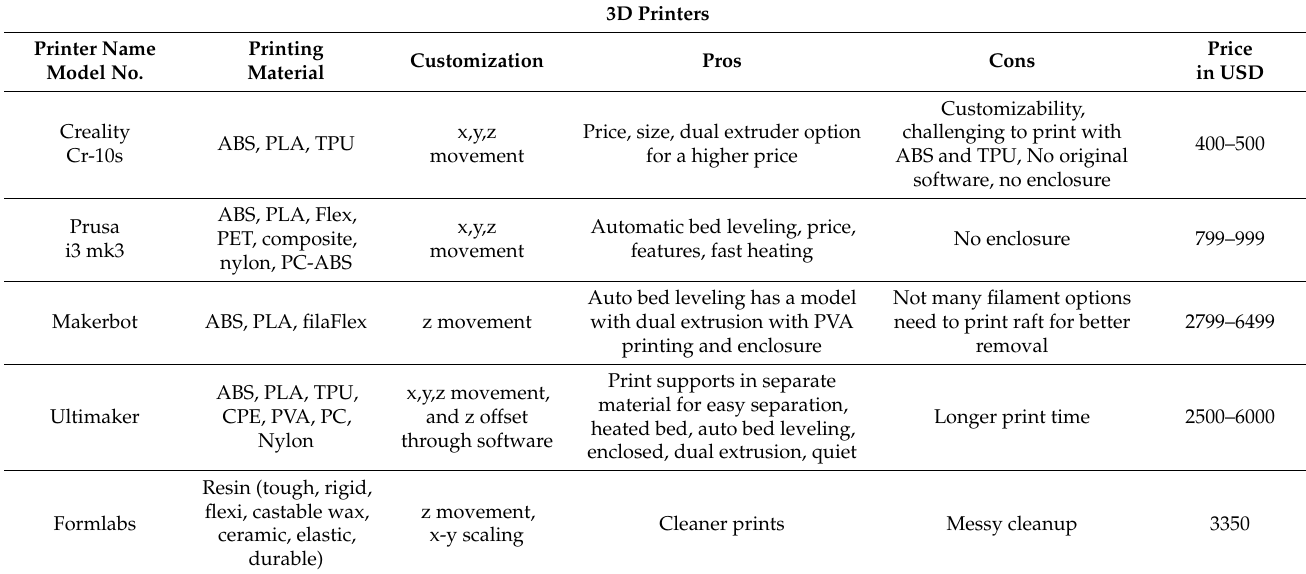
Table 1. Comparison of 5 representative desktop 3D printer